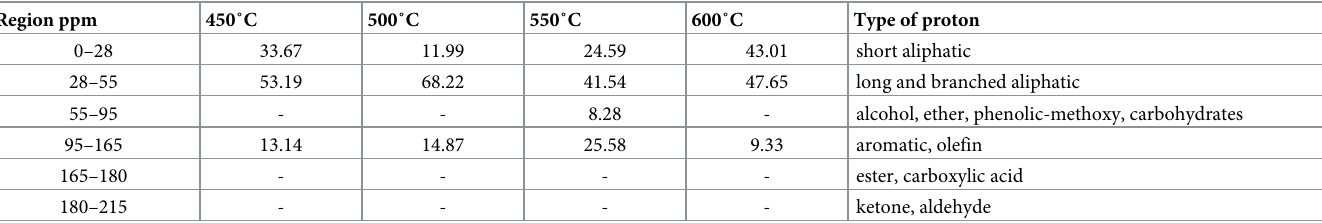
Table 3. 13 C NMR results for oil generated at different pyrolytic temperatures (in area